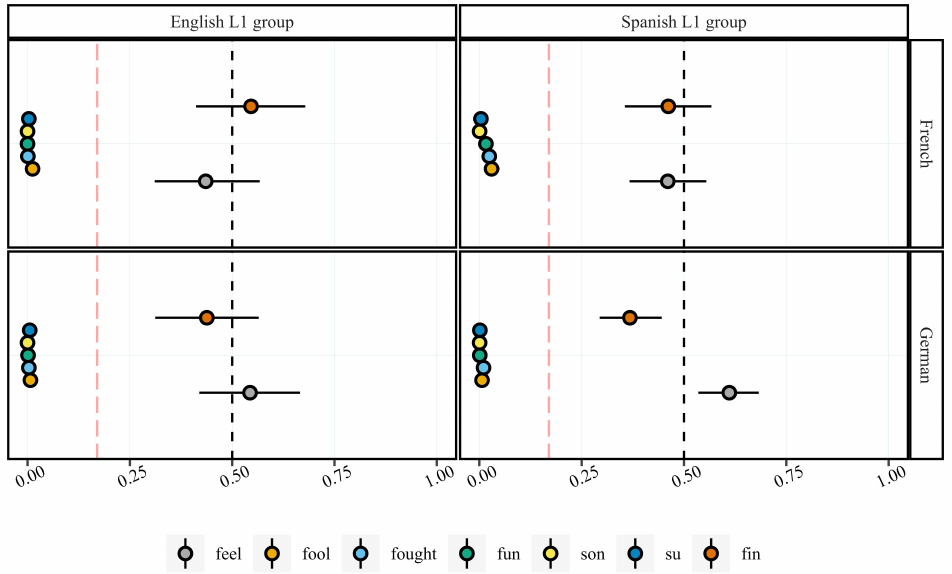
Figure 10. The probability of each answer choice given the phoneme /i/.